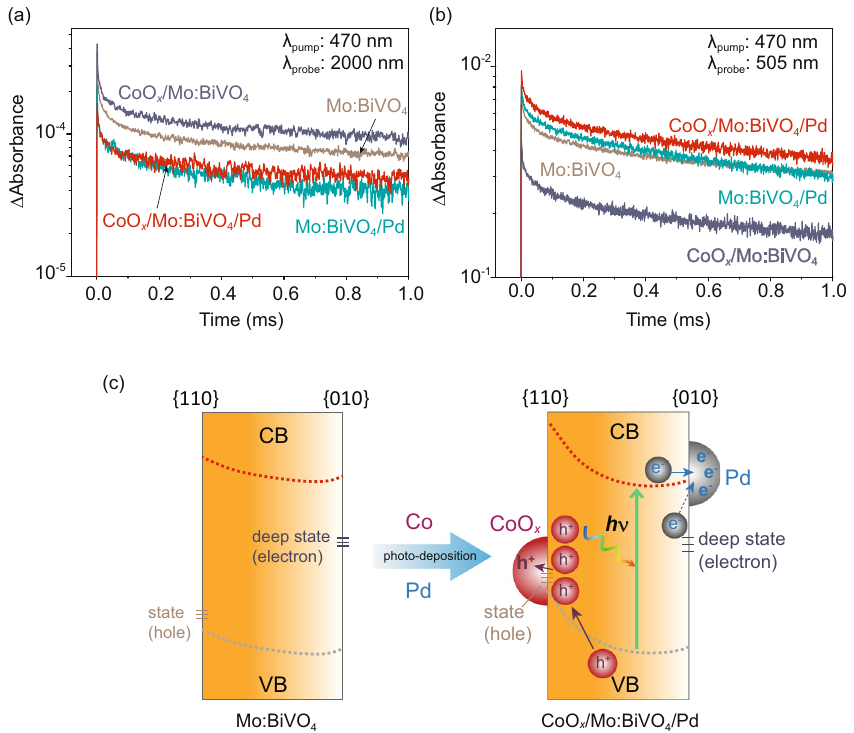
Fig. 4 Charge-carrier dynamics at microsecond time-scale and impacts of cocatalysts on the energetics of Mo:BiVO 4 facets. Transient pro fi les of photocarriers probed a at 2000 nm (free/shallowly trapped electrons) and b 505 nm (trapped holes) for Mo:BiVO 4 , CoO x /Mo:BiVO 4 , Mo:BiVO 4 /Pd, and CoO x /Mo:BiVO 4 /Pd. Samples were excited by 470 nm laser pulses (Surelite I, duration: 6 ns, fl uence: 3 mJ pulse − 1 , repetition: 1 Hz). c Impacts of cocatalysts on the energetics of Mo:BiVO 4 facets. determined by estimating the ratio of Δ Absorbance displayed in Fig. 4a with respect to bare Mo:BiVO 4 and CoO x /Mo:BiVO 4 for Mo:BiVO 4 /Pd and CoO x /Mo:BiVO 4 /Pd, respectively. At 200 μ s, for instance, 59% and 42% of free/shallowly trapped electrons remained in Mo:BiVO 4 for Mo:BiVO 4 /Pd and CoO x /Mo:BiVO 4 / Pd, respectively. This implies that 41 and 58% of free/shallowly trapped electrons transferred to Pd for Mo:BiVO 4 /Pd and CoO x / Mo:BiVO 4 /Pd, respectively. More electrons transferred to Pd on CoO x /Mo:BiVO 4 /Pd than on Mo:BiVO 4 /Pd because of more ef fi cient charge separation (synergistic charge separation) in the former case. To further justify this effect, the impact of CoO x and Pd on the decay kinetics of trapped holes in Mo:BiVO 4 was investigated.